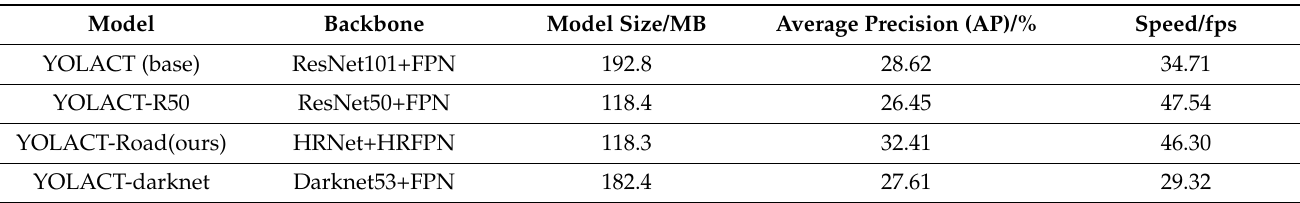
Table 1. YOLACT model performance of different backbone